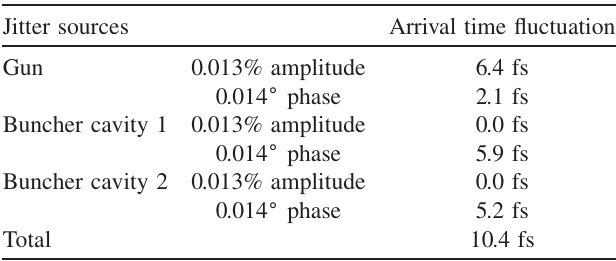
TABLE III. Beam arrival time fluctuation at the sample pro- duced by rf jitter, 0.013% amplitude and 0.014 (cid:3) phase, at the gun and buncher. Total arrival time jitter was estimated by adding each jitter contribution quadratically.